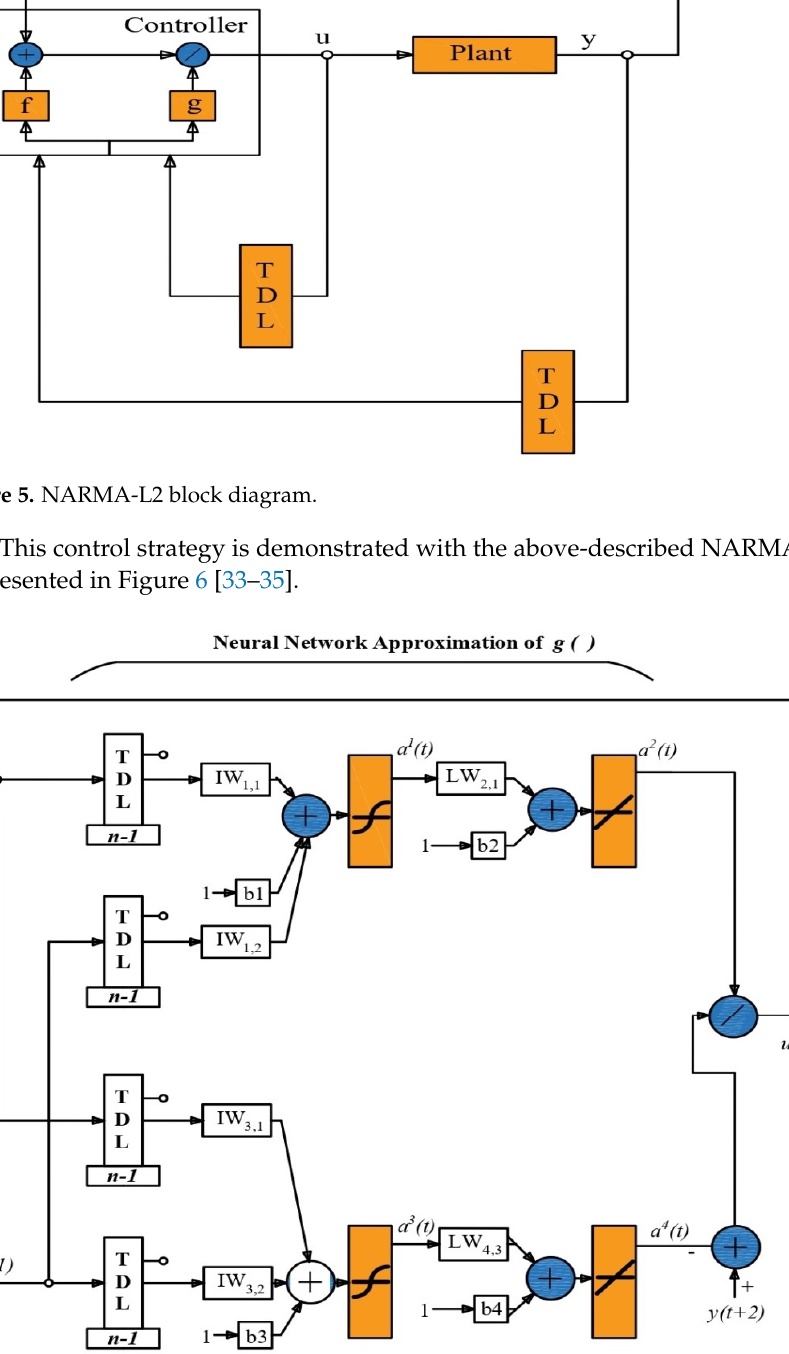
Figure 6. NARMA-L2 with the neural network model.